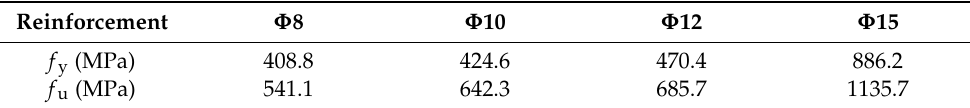
Figure 1. Details of specimen and measurements. ( a ) Dimensions of the specimens; ( b ) Measurements. Table 1. Material properties of reinforcements.